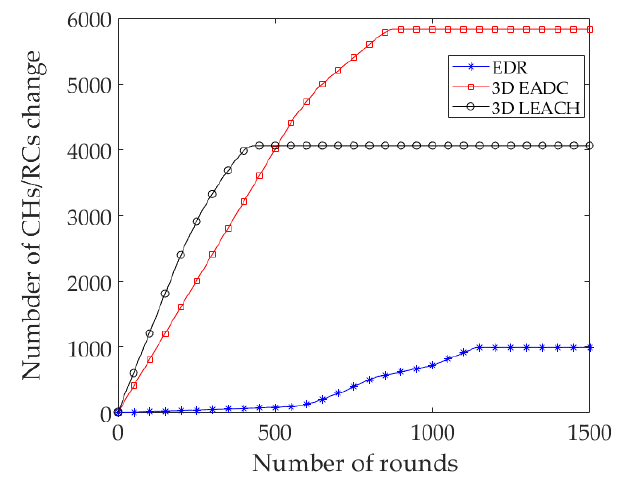
Figure 3. The CH/RC nodes changed at different rounds.